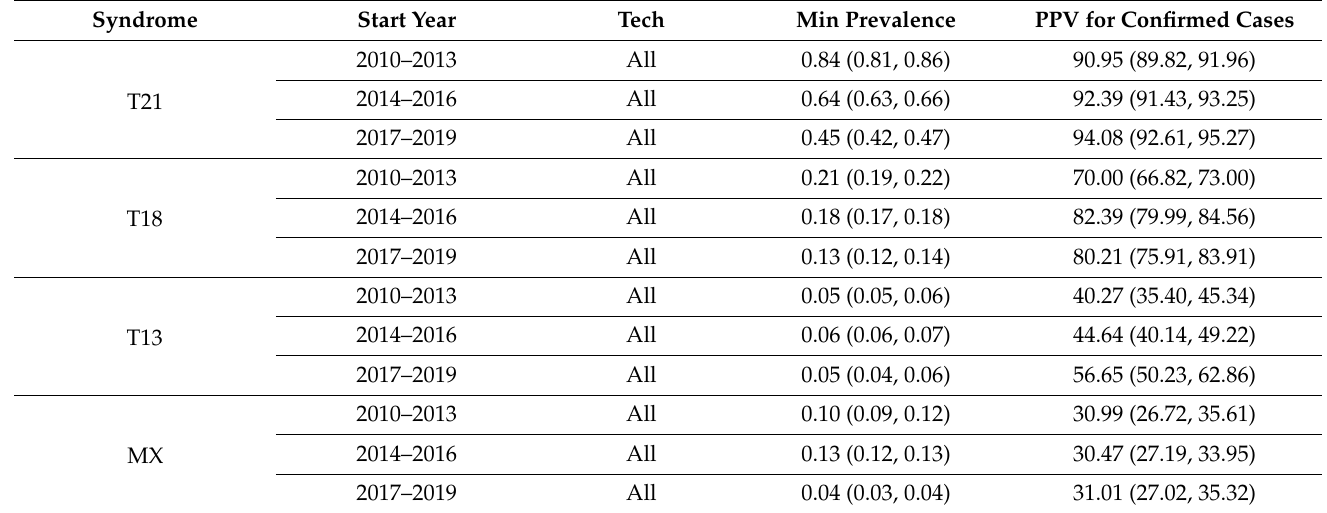
Table 7. Clinical experience studies: pooled estimates by syndrome and study start